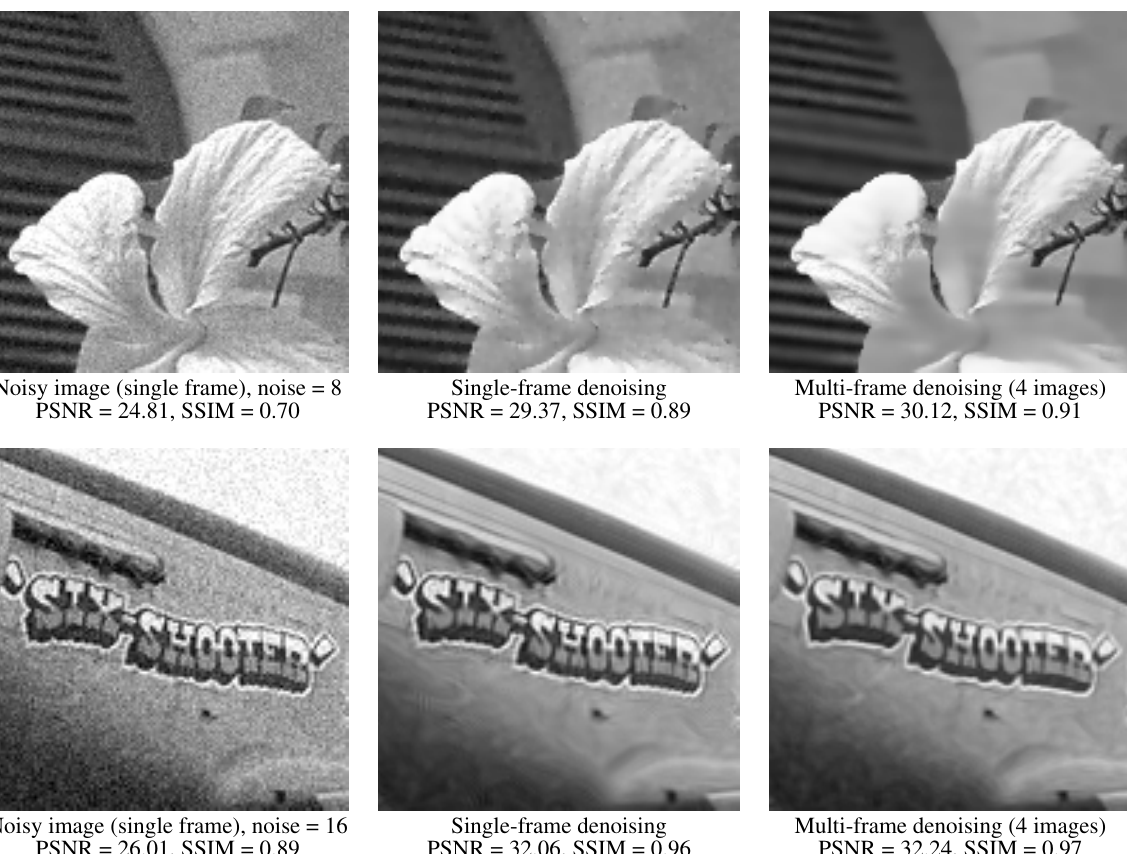
Figure 2. The results of single- and multi-frame image denoising